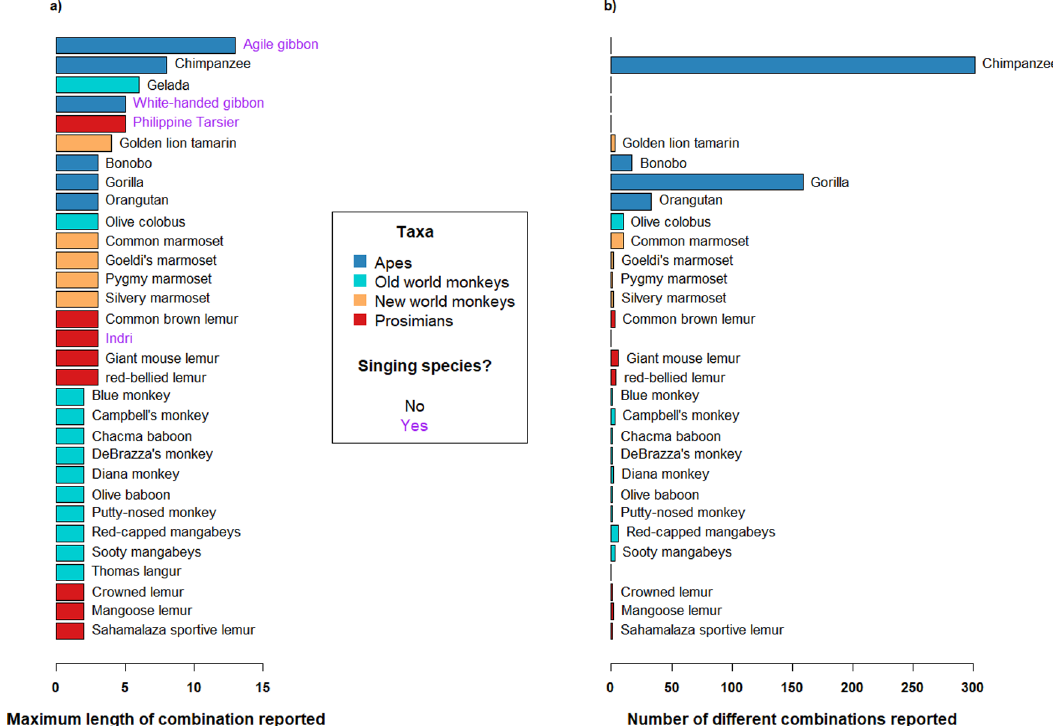
Fig. 6 A literature review comparing vocal sequencing across primates. The barplot on the left indicates the maximum length of sequences reported in each species (i.e., the number of unique single units emitted in a single sequence) ( a ). The barplot on the right indicates the number of different sequences reported to comprise at least two different single units ( b ). We counted sequences in which different single units occurred at least once. If the same single unit was repeated later in the sequence this was not counted as a new sequence. Species showing no number of different sequences may re fl ect lack of published information. The color of the bars in both plots indicate the taxa of the species. Apes (including great and lesser apes), old-world monkeys, new- world monkeys, and prosimians are depicted in dark blue, light blue, orange, and red respectively. The singing species are indicated by the purple text. Singing species are species such as Indris or gibbons which emit different single units in song. These units are not necessarily emitted singularly nor in other parts of the vocal repertoire. Superscript numbers refer to the relevant citations listed